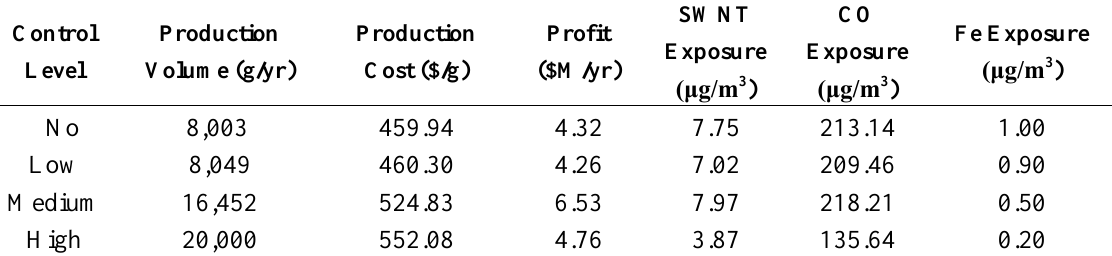
Table 5. Results of the NLP